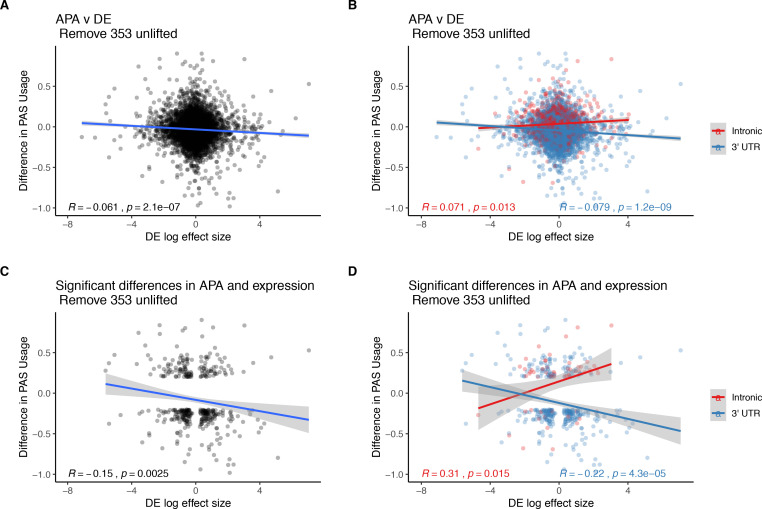
Figure 3 without genes affected by liftover.(A) Changes in polyadenylation site usage (∆PAU) for top intronic or 3' UTR polyadenylation sites (PAS) per gene plotted against differential effect size from differential expression analysis. (B) ∆PAU for top intronic or 3' UTR PAS per gene plotted against differential effect size from differential expression analysis for genes with significant differences in each phenotype at 5% FDR. (C) ∆PAU for top intronic or 3' UTR PAS per gene plotted against differential effect size from differential expression analysis. (D) ∆PAU for top intronic or 3' UTR PAS per gene plotted against differential effect size from differential expression analysis for genes with significant differences in each phenotype at 5% FDR. In all panels, we calculated the linear regression and Pearson's correlation with the r package ggpubr. In B and D, we colored the points and regression line by genic location. In all panels, negative ∆PAU and DE effect sizes represent upregulation in chimpanzees.